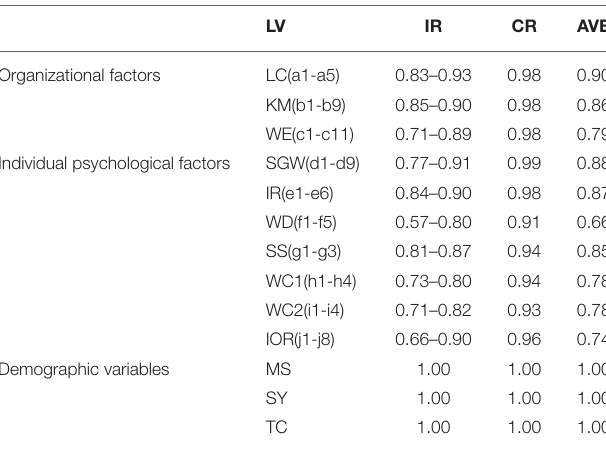
TABLE 3 | Reliability test results of the outer model. LV IR CR